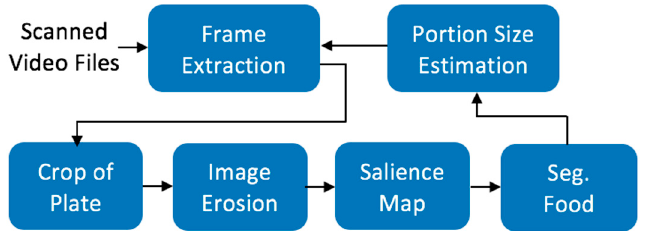
Figure 13. The architecture system design of the volume measurement algorithm.